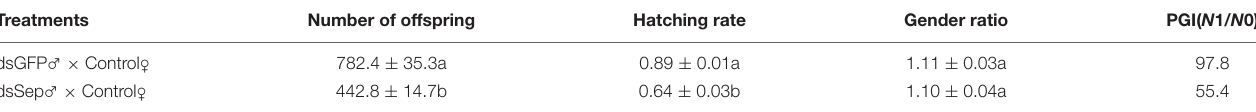
FIGURE 11 | The influence of dsSPF-L-treated males on morphology of male spermaducts and spermathecae of their partners, with DAPI staining at 2 DAE. (A) An expanded spemateca filled with sperm and seminal fluids. (B) A much smaller, unfilled spermatheca after mating with a dsSPF-L-treated partner. (C) An intact spermaduct from a control-treated BPH. (D) A much reduced spermaduct from a SPF-L-treated BPH. (E,F) Display the overall male reproductive anatomy of dsSPF-L-treated and dsGFP control BPHs. The images were captured using a Zeiss LSM 780 confocal microscope. TABLE 2 | Mating with dsSPF-L-treated males led to reduced egg laying, hatch rates, and PGI. Treatments Number of offspring Hatching rate Gender ratio PGI( N 1/ N